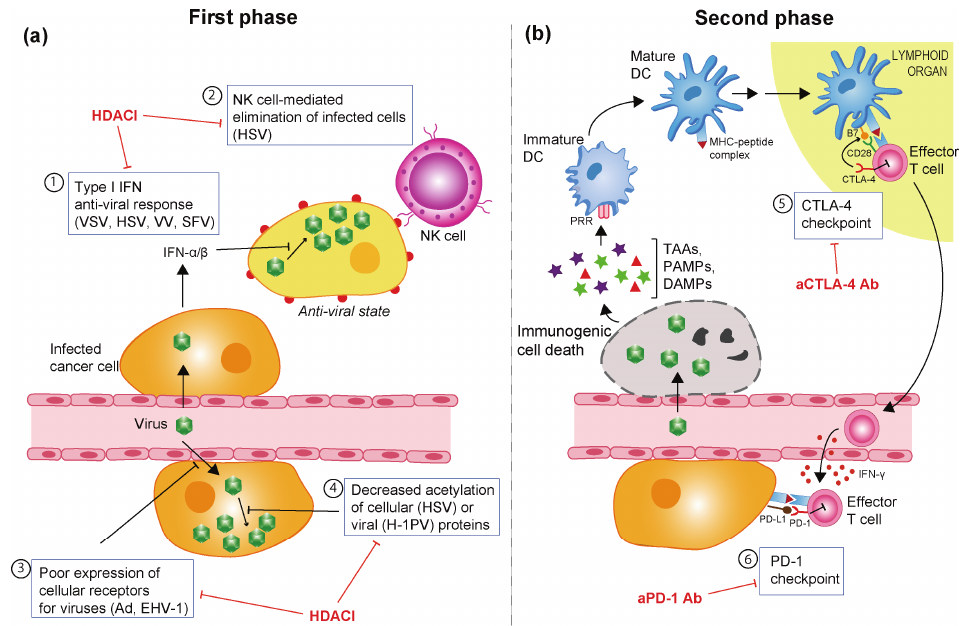
Figure 3. Combinatorial approaches to overcome barriers to OV-induced oncolysis and immune stimulation. ( a ) Multilevel stimulation of OV infection and multiplication by histone deacetylase inhibitors. The combinatorial use of HDACIs clears some of the hurdles (boxes 1–4) that limit the